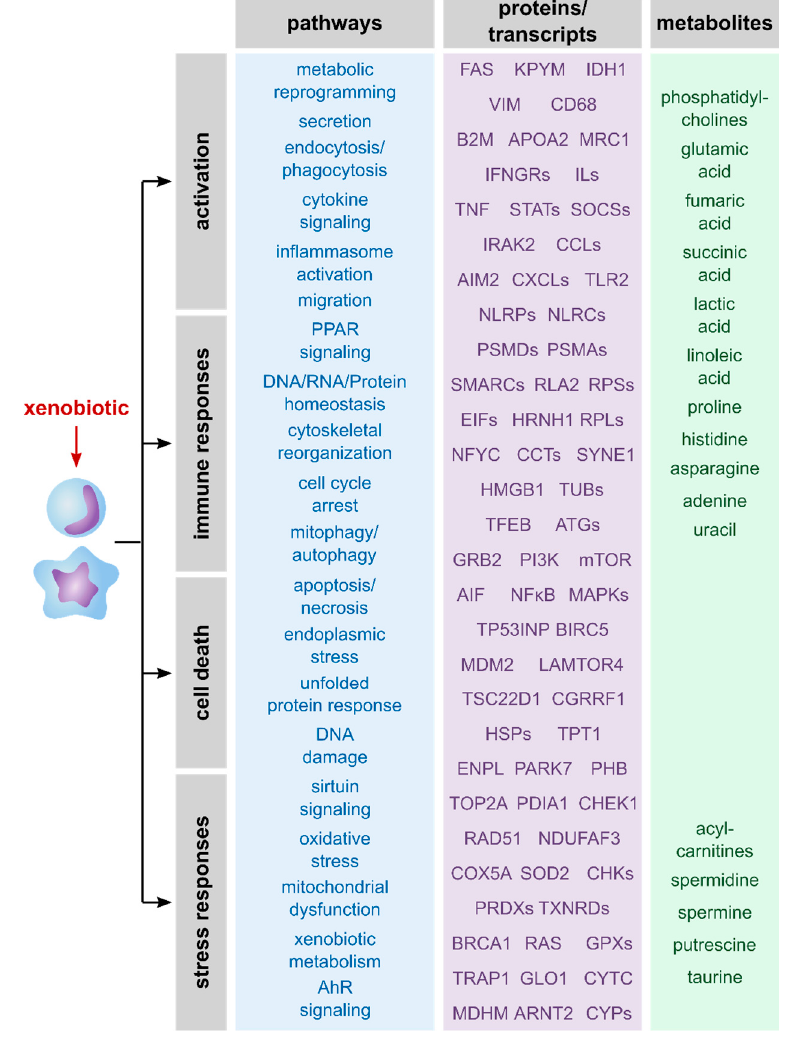
Figure 2. Overview of described effects and related transcripts, proteins, and metabolites. Shown are effects of xenobiotics on macrophages that were described in the here reviewed publications.